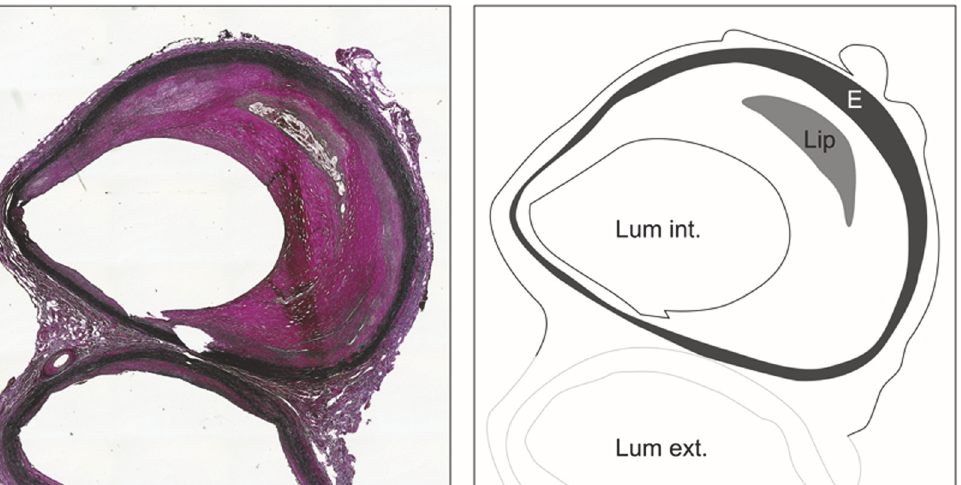
Fig 2. Histology of control sample: fibrous cap atheroma. Histology of control sample. Sample taken just distal from the bifurcation. Elastin-van Giesson (EvG) stain. In black the elastic fibers are clearly present and well organized. Atherosclerotic changes, atheroma with a lipid core. E, Elastin; Lip, Lipid core; Lum ext., lumen of the external carotid artery; Lum int., lumen of the internal carotid